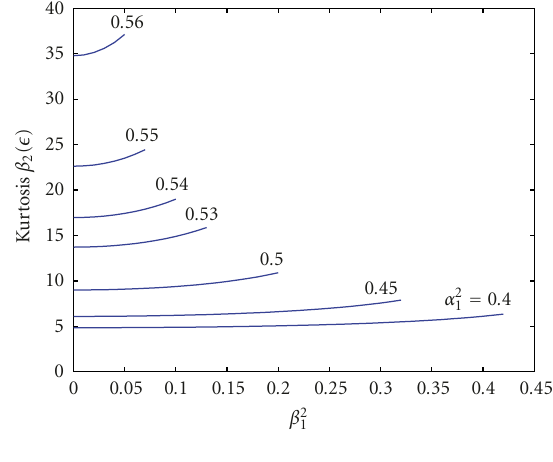
Figure 4: Kurtosis for